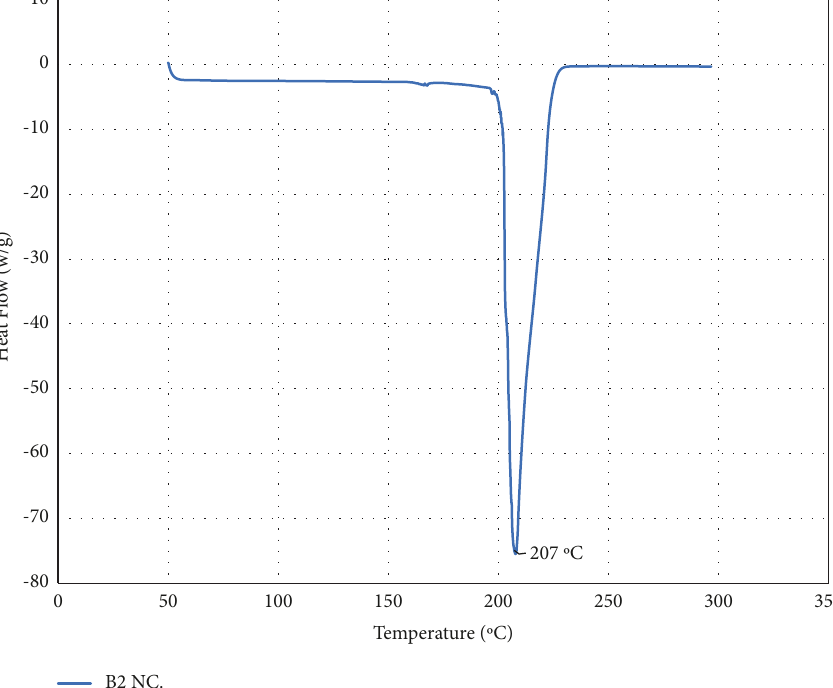
Figure 7: Diferential scanning calorimetry (DSC) analysis of a sample treated ( B 2) with, showing an endothermic peak typical of nanocellulose (207 ° C), obtained by acid hydrolysis 64% sulfuric acid (H 2 SO 4 ). (source: author